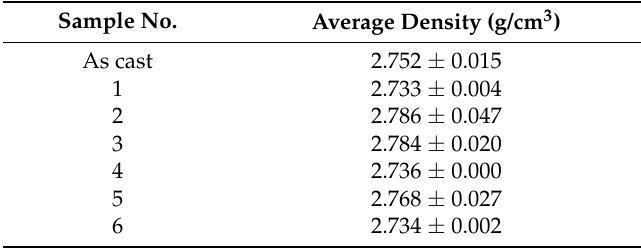
Table 4. Density measurements performed on 356 Al alloy: 1—after vibration by 100 Hz; 2—after vibration by 150 Hz; 3—after modification by ultrafine powder modifier followed by 200 Hz vibration; 4—after modification by ultrafine powder modifier; 5—after modification by ultrafine powder modifier followed by 100 Hz vibration; 6—after modification by ultrafine powder modifier followed by 150 Hz vibration; As cast—unmodified and untreated alloy.